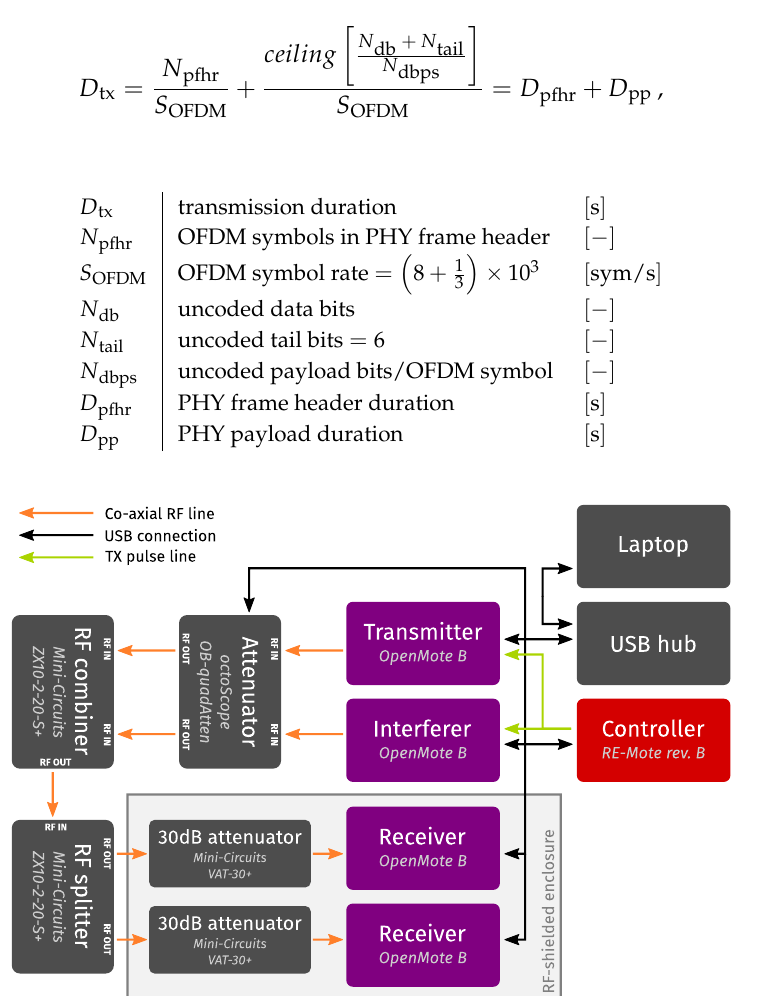
Figure 3. Measurement setup for robustness evaluation of SUN-OFDM against intra-technology/ intra-network interference. A µ-controller handles transmission timings and all Radio Frequency (RF) connections are shielded co-axial cables. Note the RF shielding enclosure around the receivers to block external interference